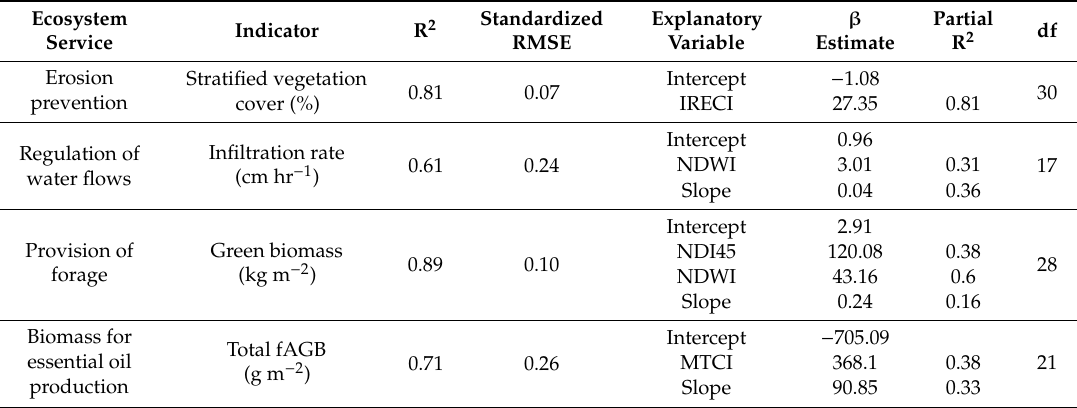
Table 2. The selected ecosystem service linear models based on Sentinel-2 and terrain variables; RMSE: root mean squared error; fAGB; fresh aboveground biomass